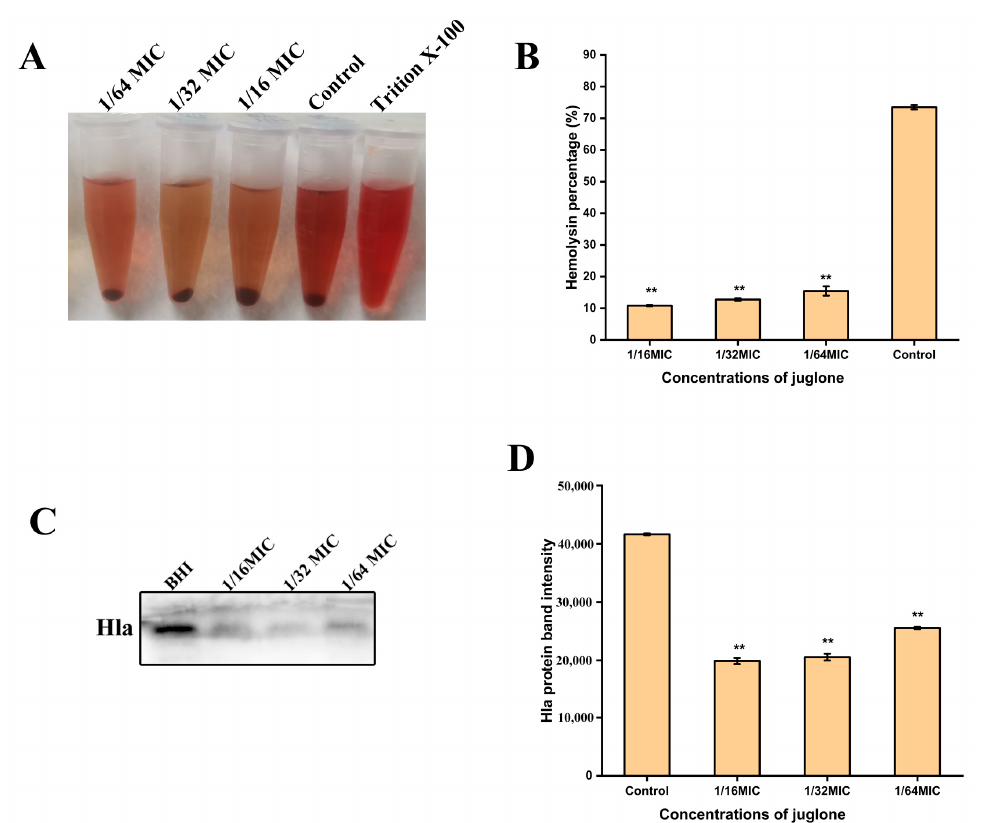
Figure 6. The effect of juglone on the hemolytic activity of S. aureus . ( A , B ) Six percent fresh sheep erythrocytes were used to analyze the hemolytic activity of S. aureus when sub-inhibitory concen- trations of juglone were treated with S. aureus for 24 h; ( C , D ) Western blot analysis of the effect of sub-inhibitory concentration of juglone on protein Hla expression of S. aureus . MIC is 1000 µ g/mL. When p < 0.01, it is represented by **.